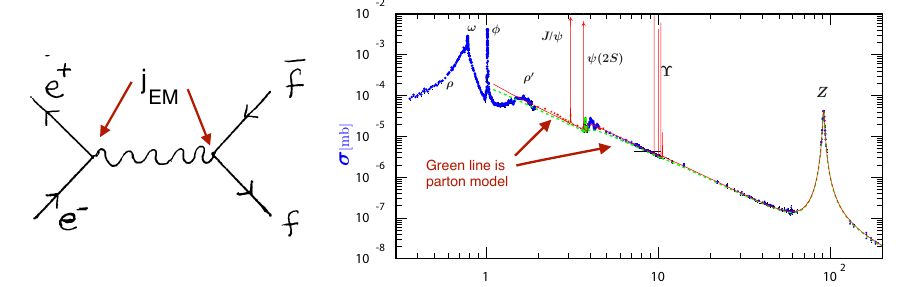
Figure 1: Left: The electroweak process mediating the annihilation of lepton pairs to hadrons. Right: The total cross section for electron-positron annihilation to